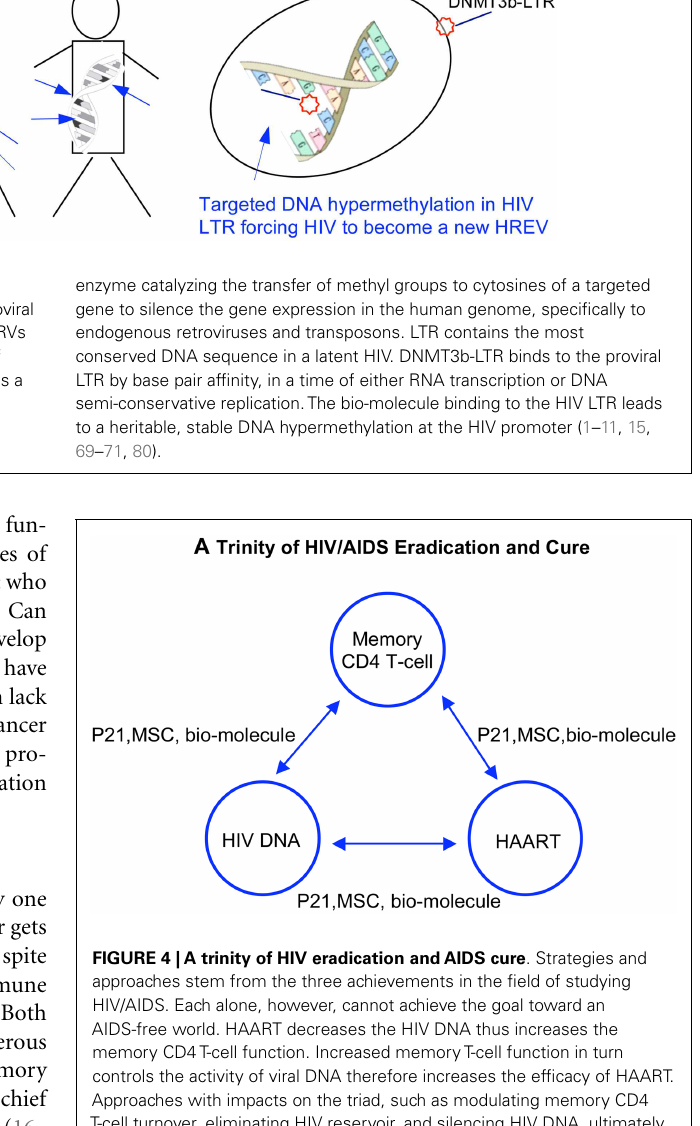
FIGURE 4 |A trinity of HIV eradication andAIDS cure . Strategies and approaches stem from the three achievements in the field of studying HIV/AIDS. Each alone, however, cannot achieve the goal toward an AIDS-free world. HAART decreases the HIV DNA thus increases the memory CD4T-cell function. Increased memoryT-cell function in turn controls the activity of viral DNA therefore increases the efficacy of HAART. Approaches with impacts on the triad, such as modulating memory CD4 T-cell turnover, eliminating HIV reservoir, and silencing HIV DNA, ultimately lead to reprogram memory CD4T-cell repertoire and patient anti-HIV immunity. An AIDS-free world will be built on patient immunity against HIV, regulated by memory CD4T-cells endowed with long living, self-renewing, and differentiating into antigen specific effector cells to control HIV provirus